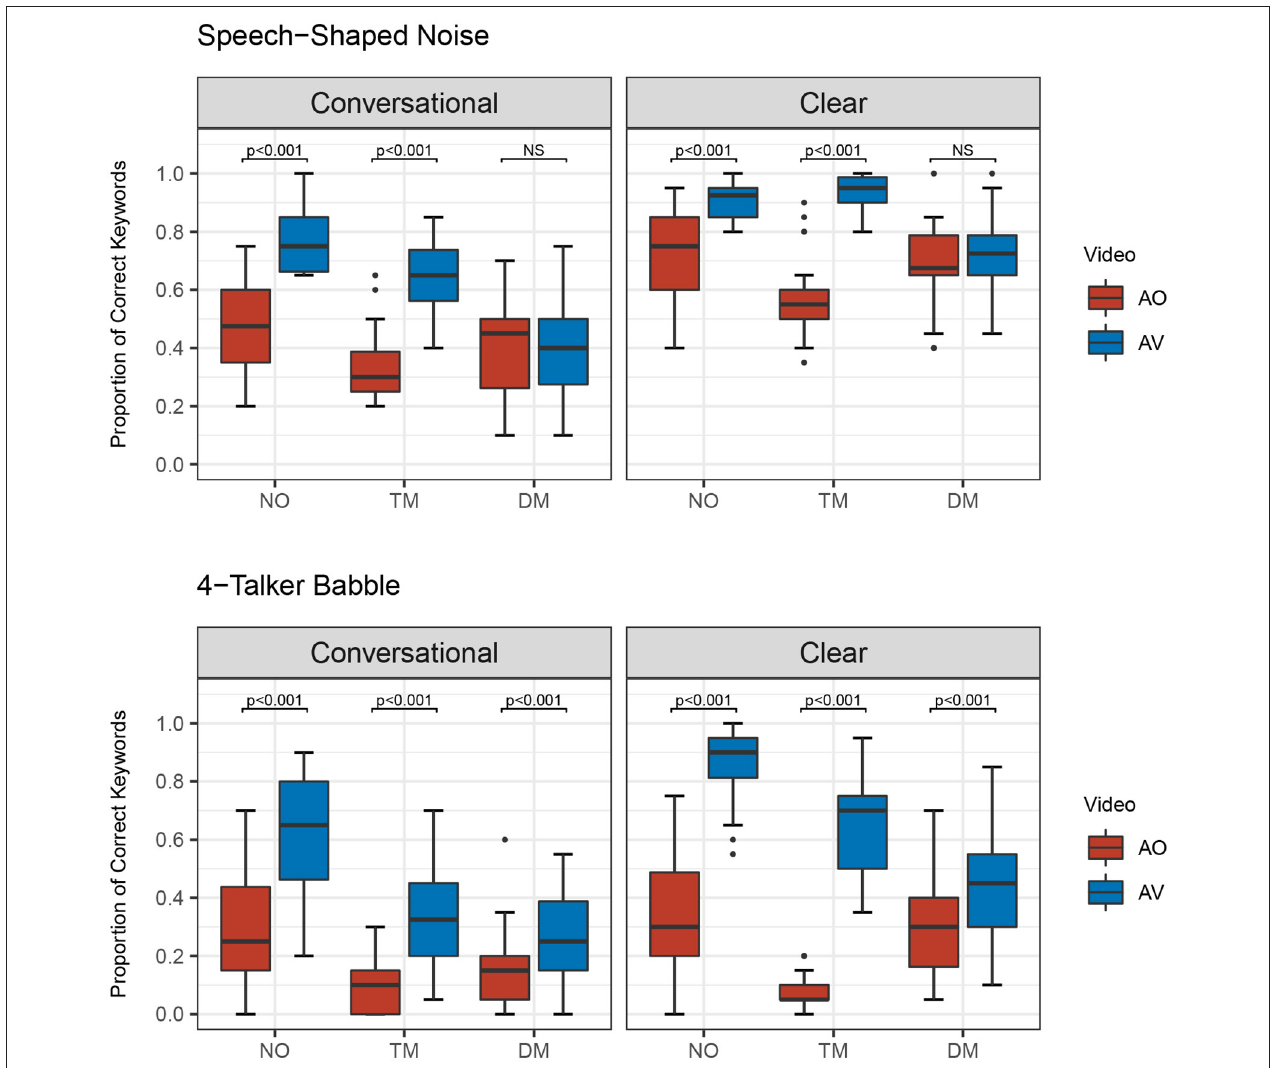
FIGURE 4 | Proportion of correct keywords in sentences for comparisons of Audio only (AO) and Audiovisual (AV) modes for each type of face mask (no mask: NO, transparent mask: TM, disposable face mask: DM) in both background noises and speaking